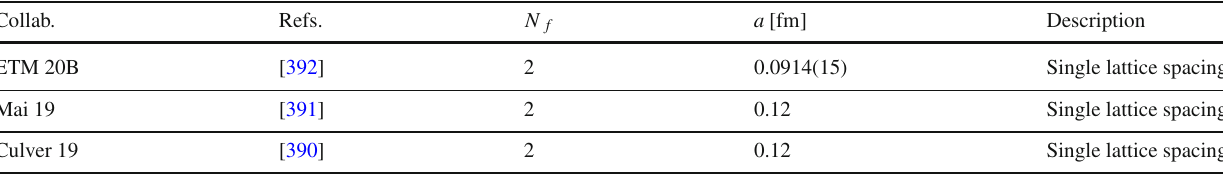
Table 111 Continuum extrapolations/estimation of lattice artifacts in determinations of the low-energy constants related to ππ scattering Collab. Refs.